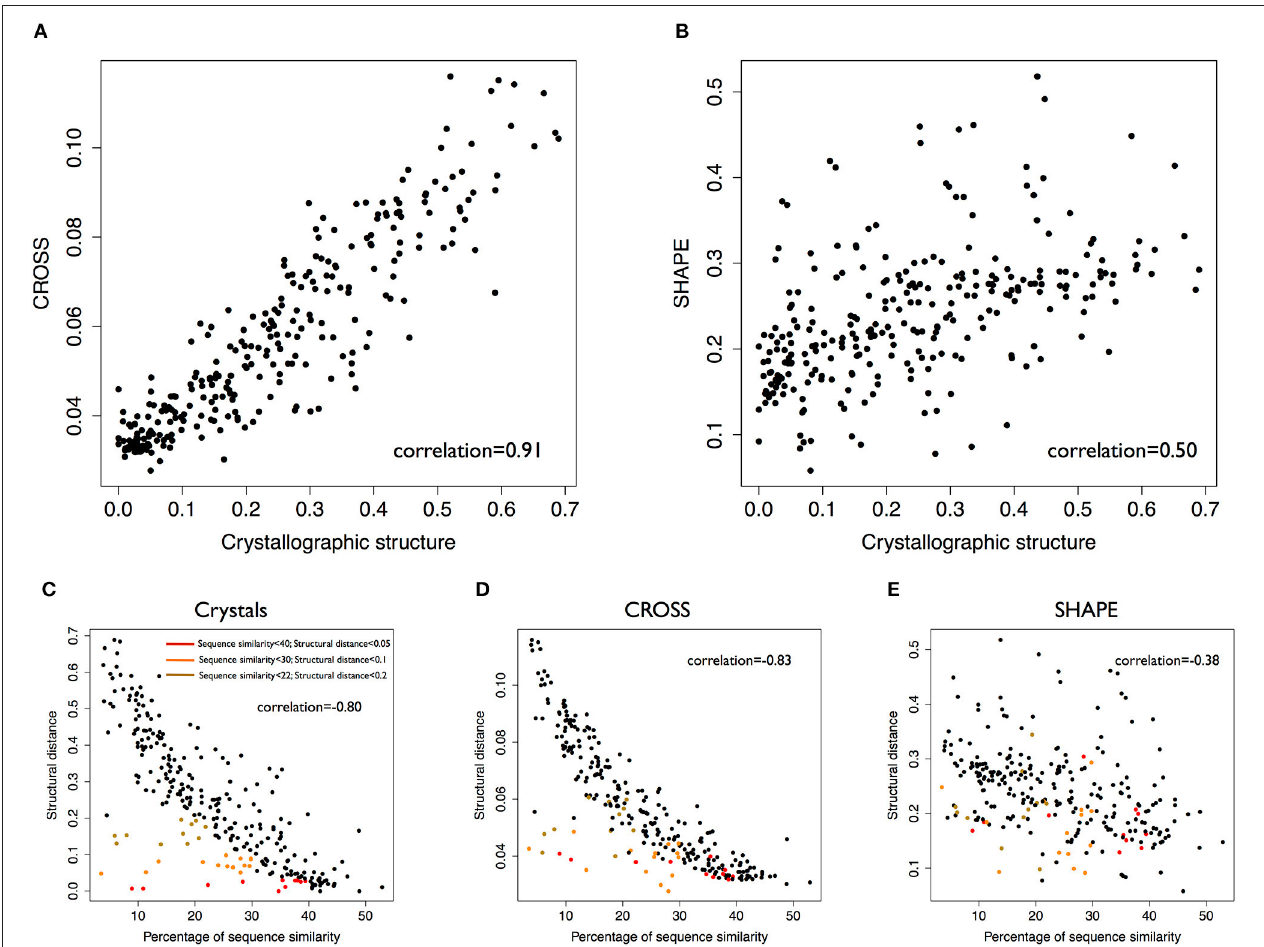
FIGURE 1 | Validation of the CROSSalign method. (A) Correlation between distances computed with CROSS and crystallographic profiles on 22 structures ( standard-DTW ). (B) Correlation between distances computed with SHAPE and crystallographic data on the same data ( standard-DTW ). (C) Correlation between structural distances (crystallographic profiles) and sequence similarity. Clusters of similar structures and different sequences (sequence similarity < 40%) are highlighted in brown (structural score < 0.2), orange (structural score < 0.1), and (red structural score < 0.05). (D) Correlation between structural distances ( CROSSalign distances) distances and sequence similarity. The clusters previously identified for crystallographic data are shown in the plot. (E) Correlation between structural distances (SHAPE) and sequence similarity. In this case the clusters are